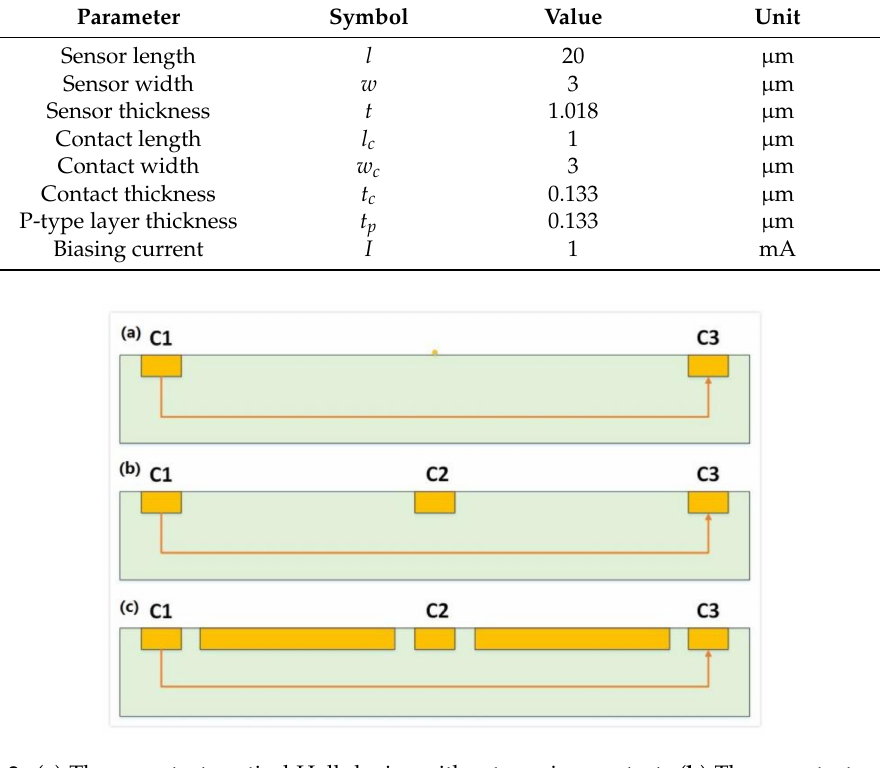
Figure 2. ( a ) Three-contact vertical Hall device without sensing contact. ( b ) Three-contact vertical Hall device with sensing contact and ( c ) three-contact vertical Hall device with sensing contact and P-type